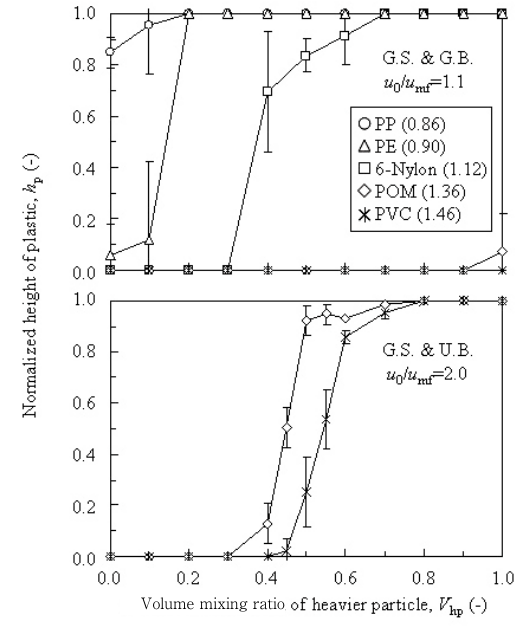
Fig.7 Apparent specific gravity of fluidized bed and the fluctuation plot- ted against volume mixing ratio of heavier particle. (P.S.(355~425 μ m, u mf = 4.7 ± 0.4 cm/s), G.B.(150~180 and 425~500 μ m, u mf = 2.9 ± 0.1 and 15.3 ± 0.9 cm/s), G.S.(355~425 and 425~500 μ m, u mf = 8.1 ± 0.3and11.6 ± 0.3cm/s), U.B.(180~212 μ m, u mf = 5.9 ± 0.1 cm/s), S.S.(75~90 μ m, u mf = 2.3 ± 0.0